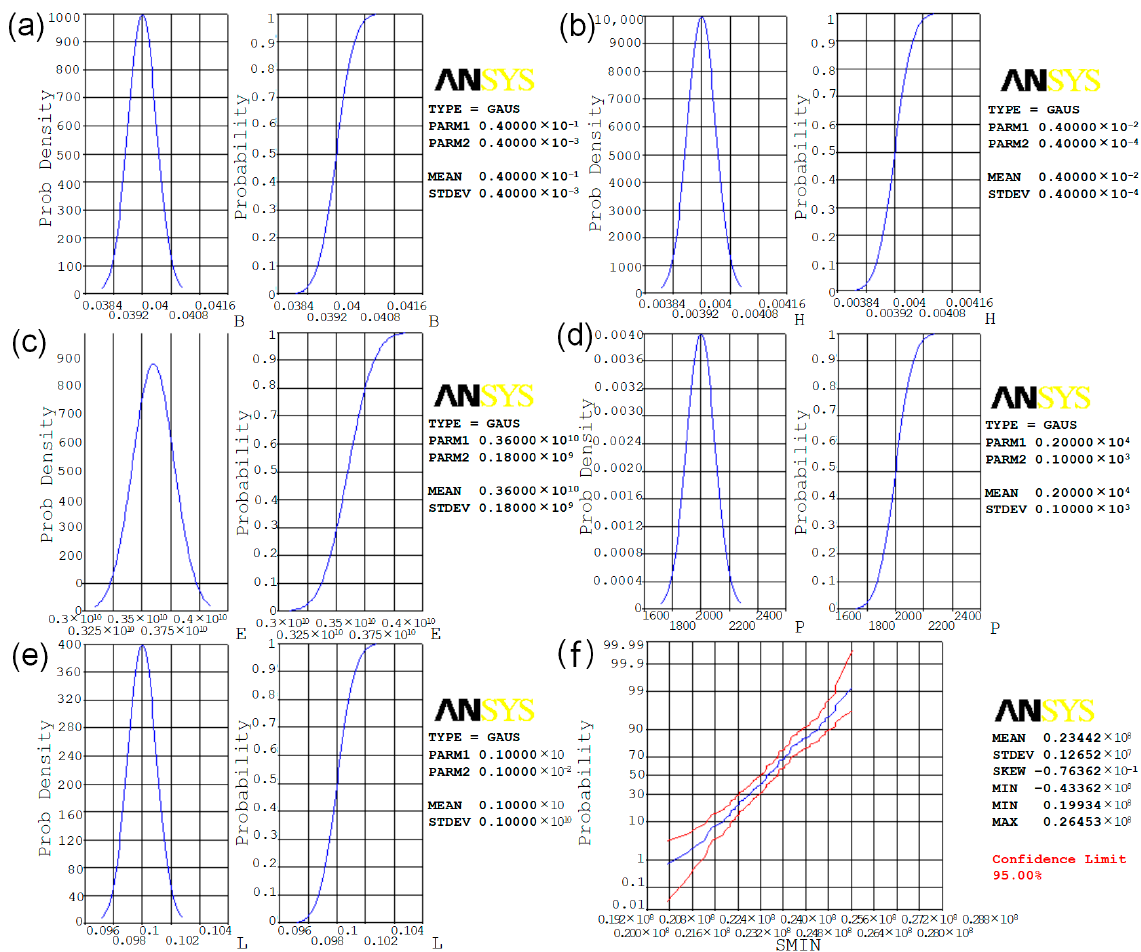
Figure 6. Probability distribution function for each random variable: ( a ) distribution curve of height; ( b ) distribution curve of width; ( c ) distribution curve of elastic modulus; ( d ) distribution curve of load; ( e ) distribution curve of length; ( f ) cumulative distribution function.